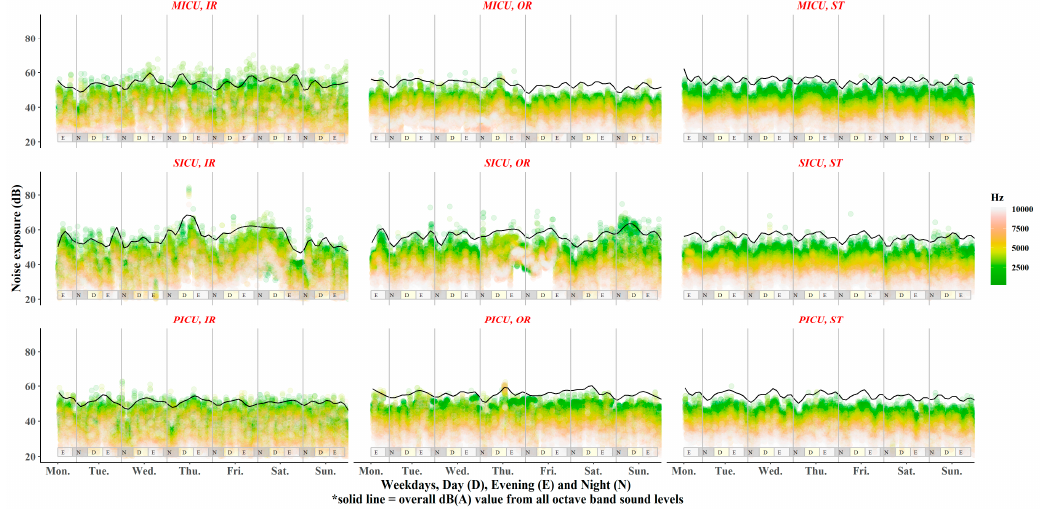
Figure 2. Noise exposure time trends of individual and overall dBA values for octave band sound levels